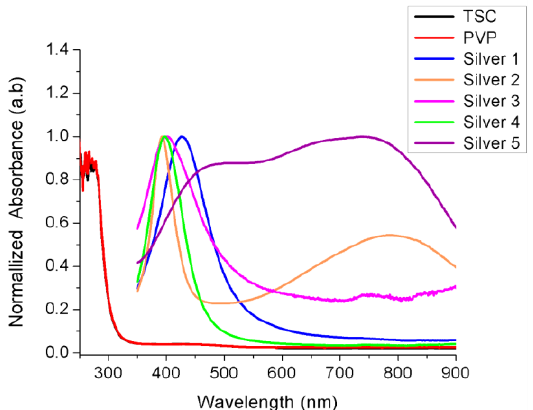
Figure 2. Ultraviolet visible (UV-VIS) absorption spectra of all samples showing different surface plasmon resonance (SPR) peaks.